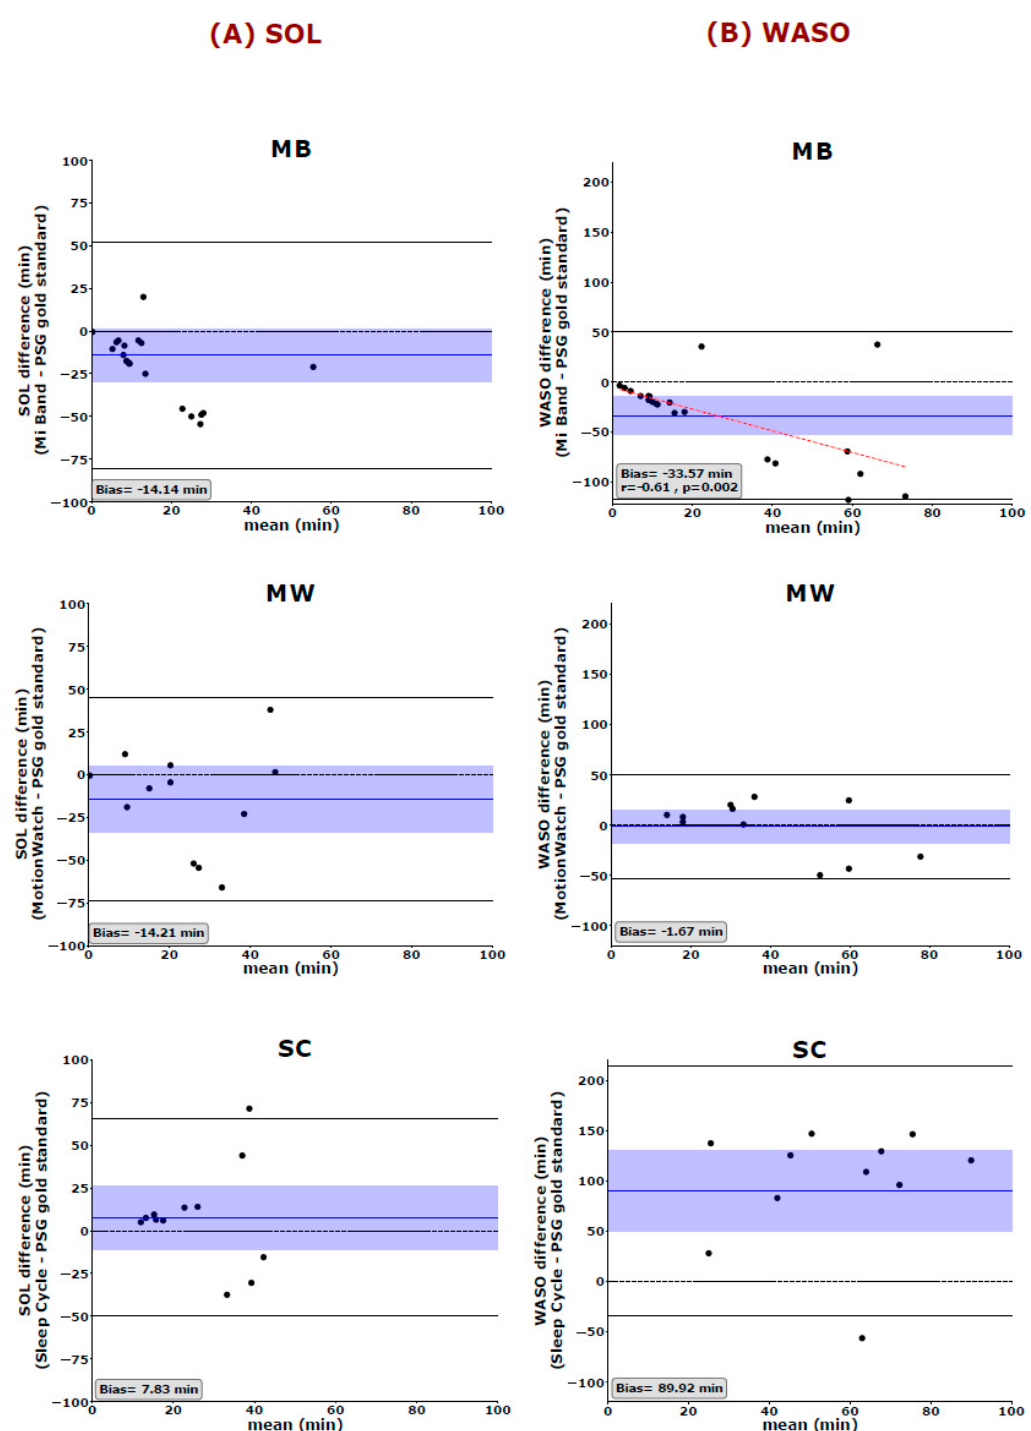
Figure 3. Bland–Altman plots of ( A ) the sleep onset latency (SOL) and ( B ) wake after sleep onset (WASO) measurements show di ff erences between the PSG gold standard and MB, MW, and SC. The blue horizontal line represents the mean di ff erence between the two measurements, and the shaded blue area represents the 95% CI of the mean di ff erence. Black horizontal lines mark the 1.96 SD from the mean. The black dashed line is the line of equality (di ff erence = 0), and the red dashed line represents the Spearman correlation between the di ff erence and the average of the two measurements. SOL: Sleep onset latency, WASO: wake after sleep onset. MB: Mi Band, MW: MotionWatch and SC: Sleep Cycle